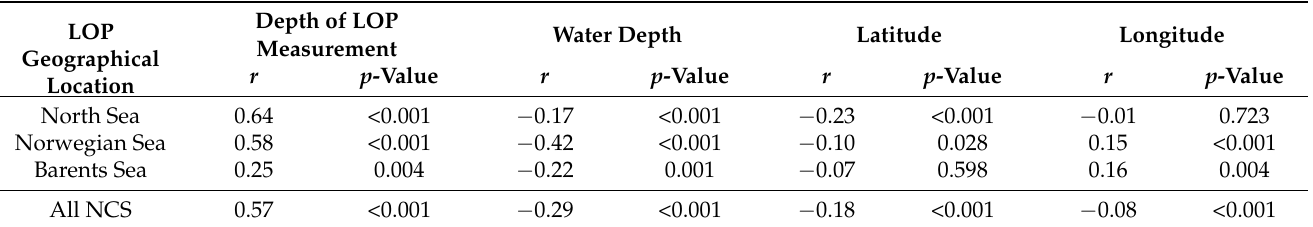
Table 3. Pearson correlation coefficients r and the p -value between leak-off pressure (LOP) and geospatial information. LOP